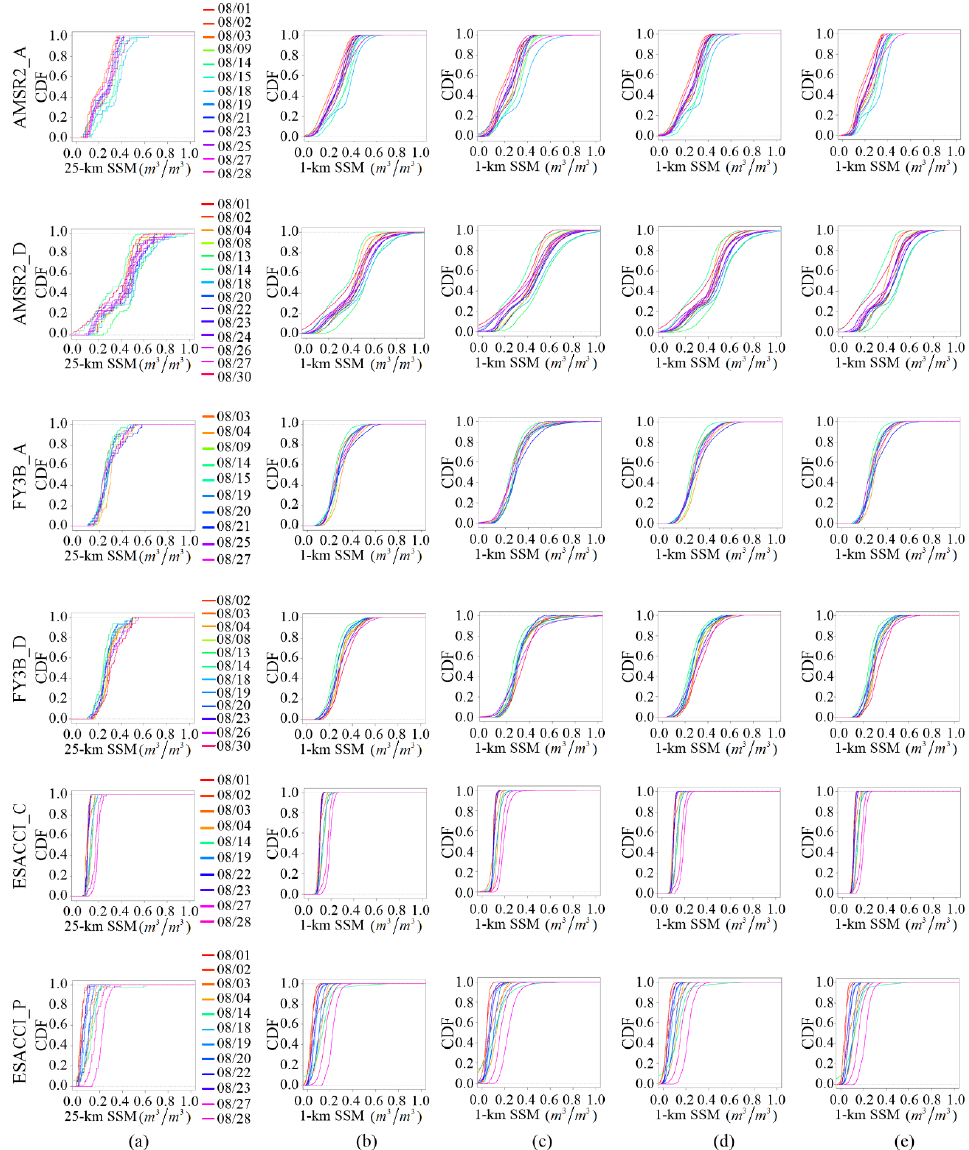
Figure 8. CDF curves for various remotely sensed products on available days within one month in the upstream HBR area: ( a ) coarse 25 km SSM products and downscaled 1 km SSM predictions derived using the four methods: ( b ) GWATPRK, ( c ) QRM, ( d ) ATPRK, and ( e ) SVR.